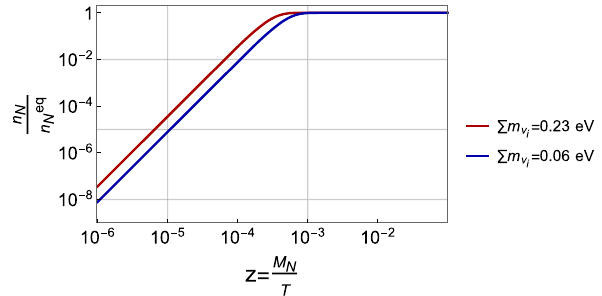
Fig. 5 The ratio of the heavy neutrino density to its equilibrium density against the dimensionless quantity z = M N T − 1 in case of (cid:20) (cid:20) = 0 . 06eV ( = 0 . 23eV) [24], corresponding to the m ν m ν i i i i lower (upper) bound on the sum of the three active neutrino masses. Since the production rate of N is proportional to the sum of the active neutrino masses this choice shows the earliest and latest point of equi- libration. The heavy neutrinos reach equilibrium for T ≈ 10 3 M N in both cases. In Fig. 4, the lower bound on the sum of the neutrino masses was used, but the results are negligibly different when considering the upper